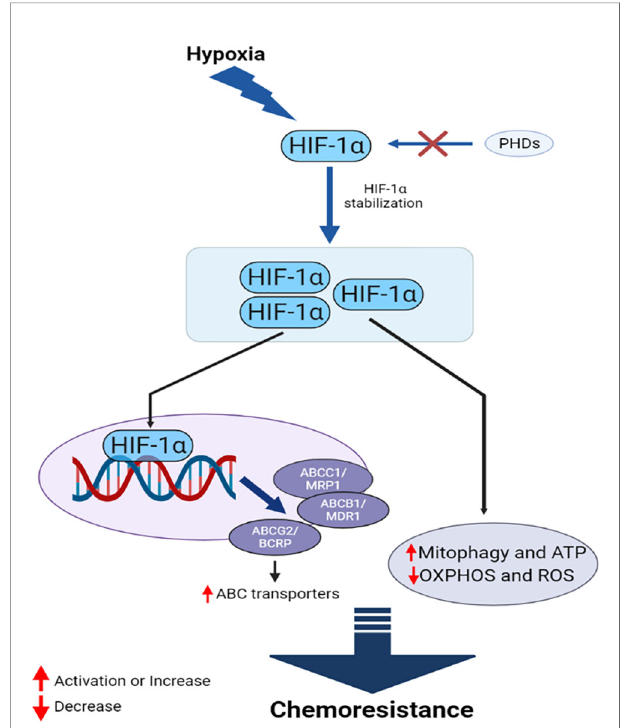
FIGURE 5 | HIF-1 a mediates interconnected mechanisms during hypoxia, facilitating chemoresistance in